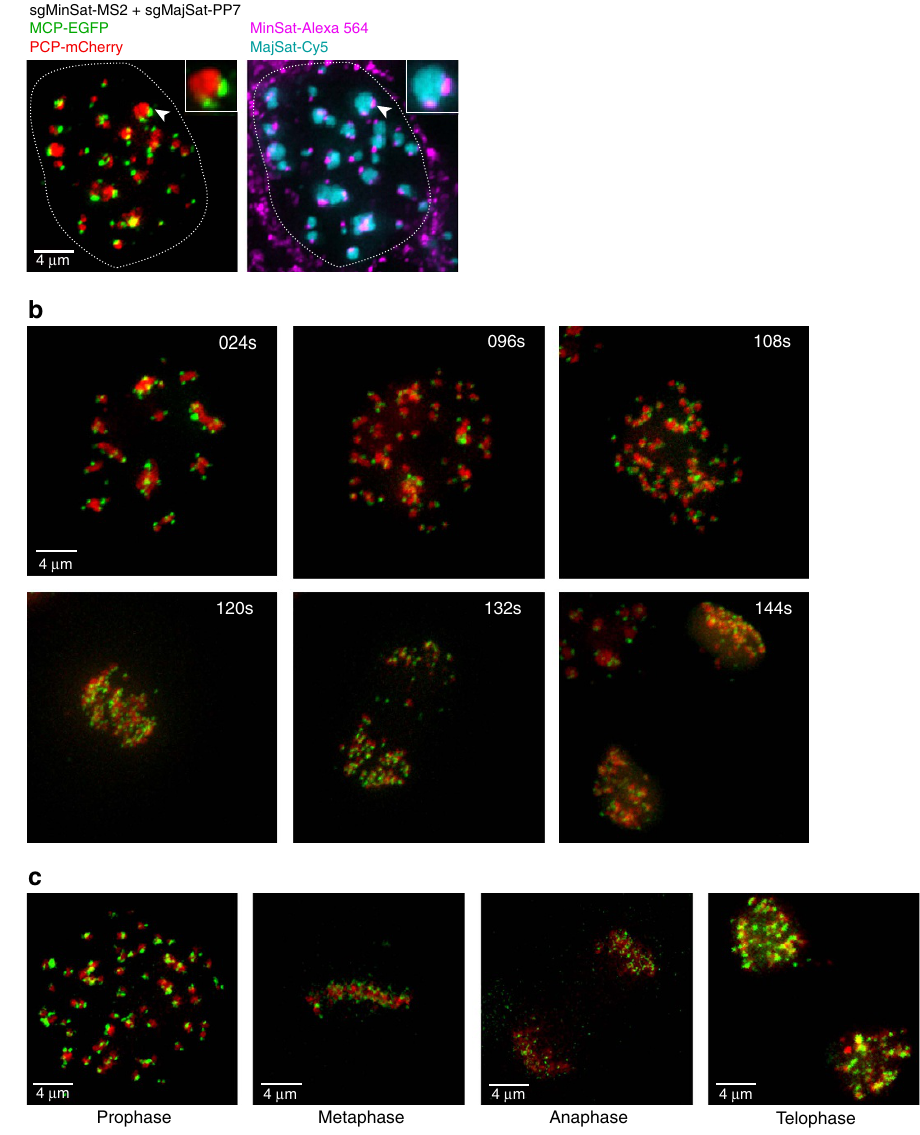
Figure 3 | Imaging of minor and major satellite regions throughout cell cycle. ( a ) 3T3 fibroblasts expressing dCas9, PCP-mCherry and MCP-EGFP were transfected with sgMajSat-PP7 and sgMinSat-MS2. Insets shows a zoomed view of a centromeric region containing the expected signal of minor and major satellites (left panel). Fluorescent protein signals were validated by DNA FISH (right panel). ( b ) One cell with labelled minor and major satellites was followed throughout cell cycle. ( c ) Cells at different stages of mitosis were captured in time-lapse live